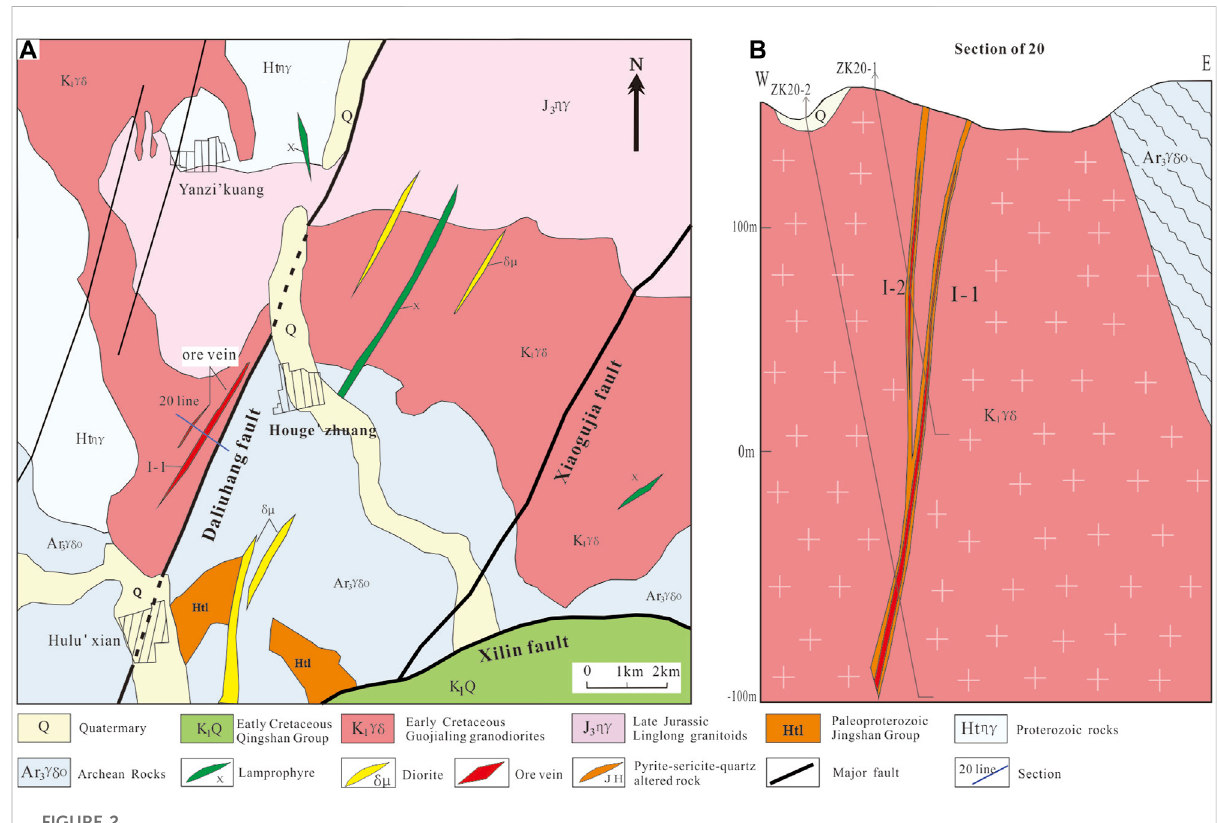
FIGURE 2 Geological map of the Houge ’ zhuang gold mining area (A) and the geological section of Line 20 (B)